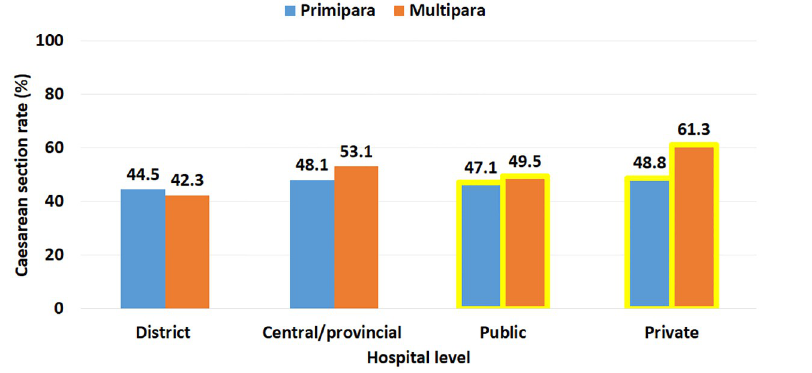
Fig 1. Caesarean section rate by level of hospitals and maternal parity, Vietnam, 2022.